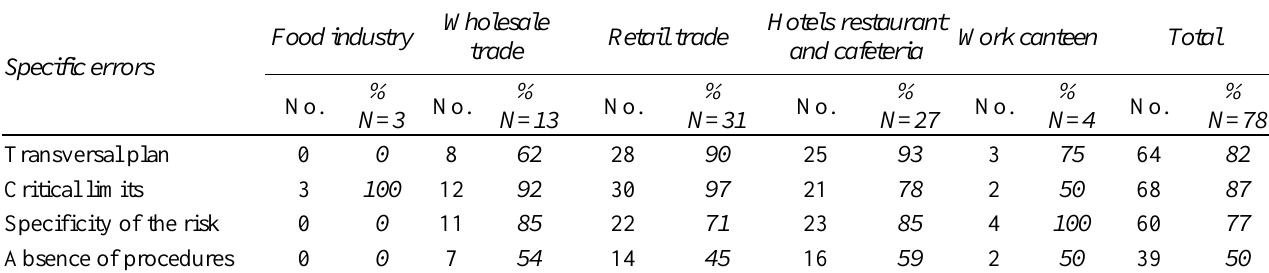
Table 7: Distribution of the general errors, for class of activity of the food companies.